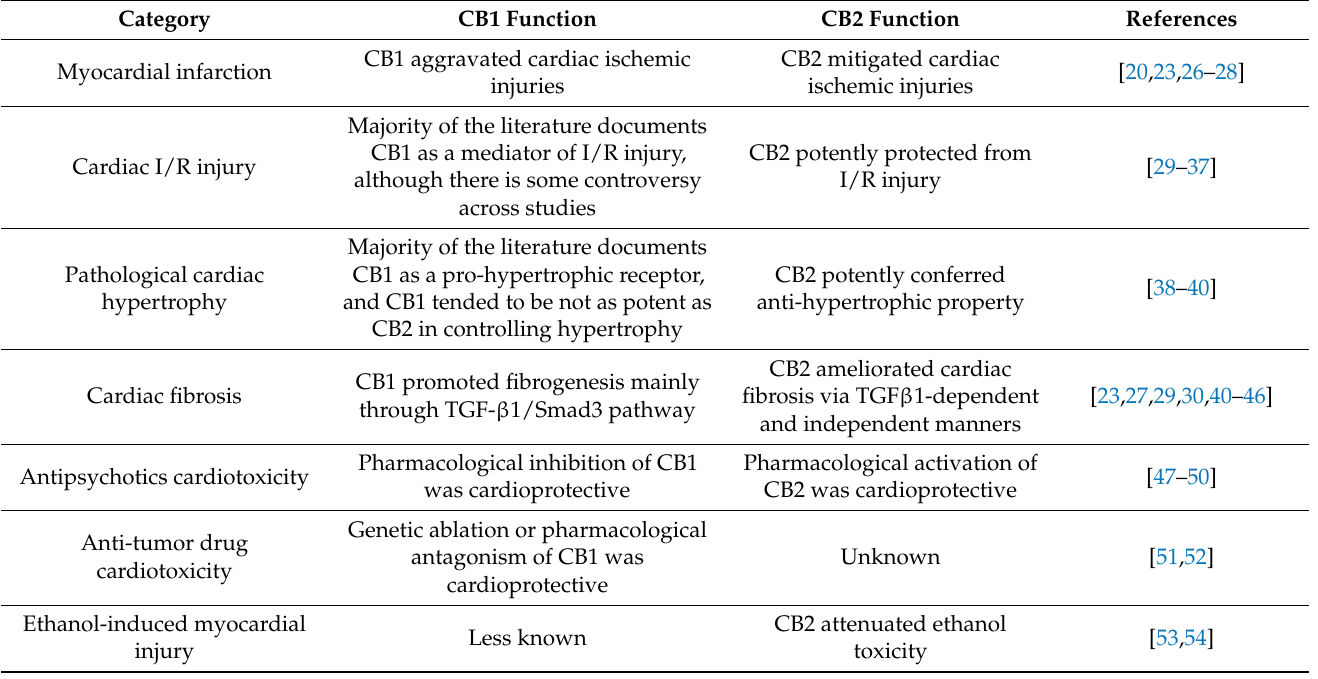
Table 1. A summary of the functional rivalry between CB1 and CB2 receptors in myocardial